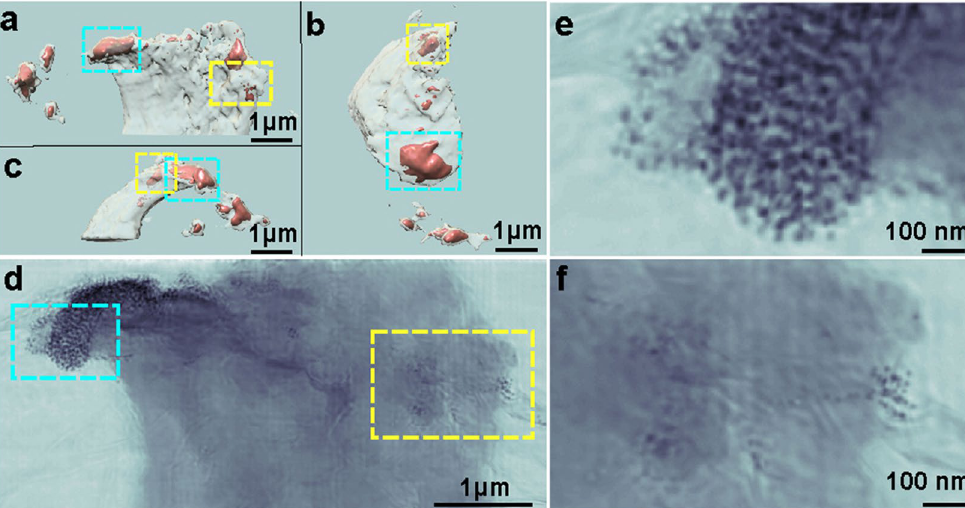
Figure 3. STXM tomography reconstruction of the leading edge of a HeLa cell. ( a – c ) Iso-renderings of the 3D reconstruction showing several high-density regions (orange) within the cell, viewed along the z-, minus y- and x-axes, respectively. ( d ) High-resolution ptychographic image confirming that the internalized high-density regions correspond to nanoparticles uptaken by the cell. ( e and f ) Magnified views of two regions in ( d ) labeled with cyan and yellow rectangles,